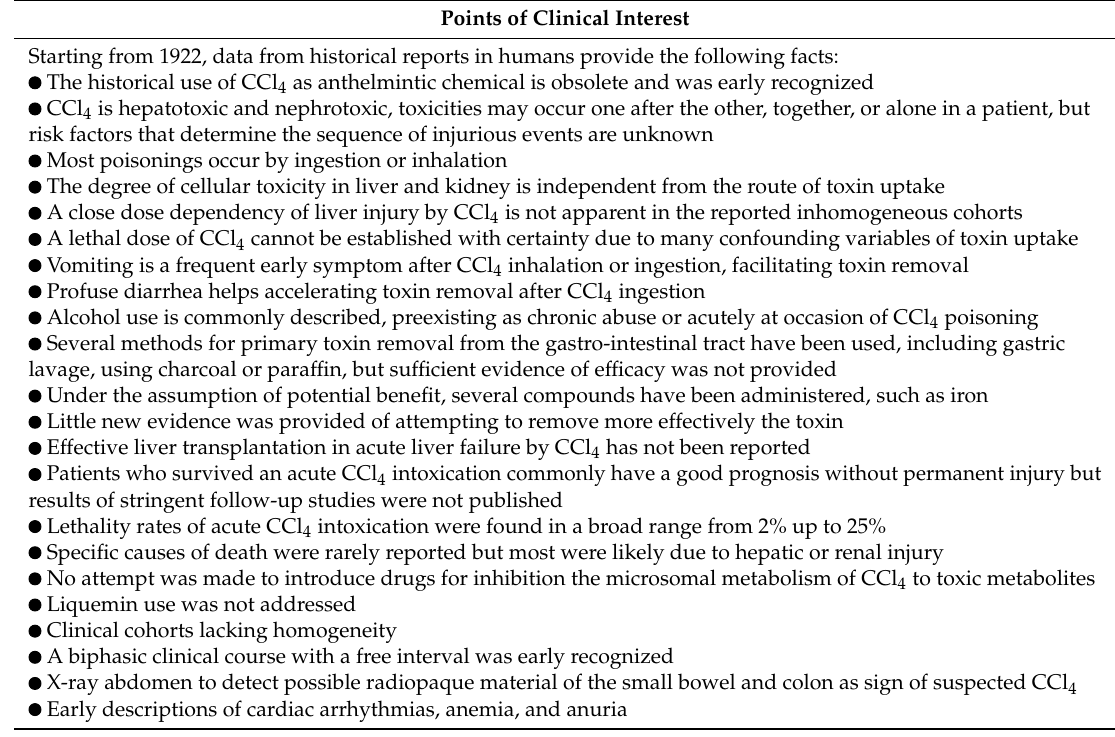
Table 2. Summary of historical data on CCl 4